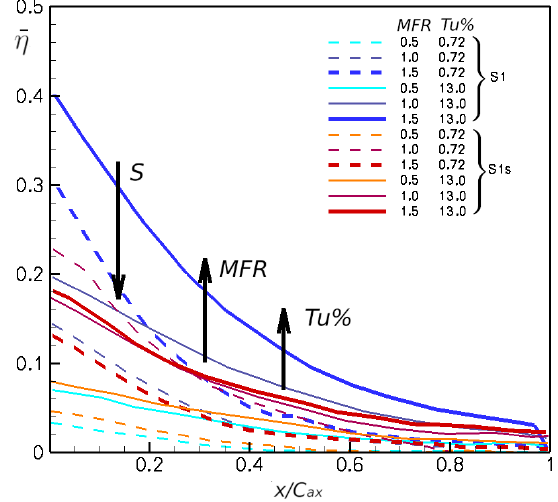
Figure 9. Platform rotor blade film cooling effectiveness as a function of operating conditions (figure newly created herein using data taken from [18]).